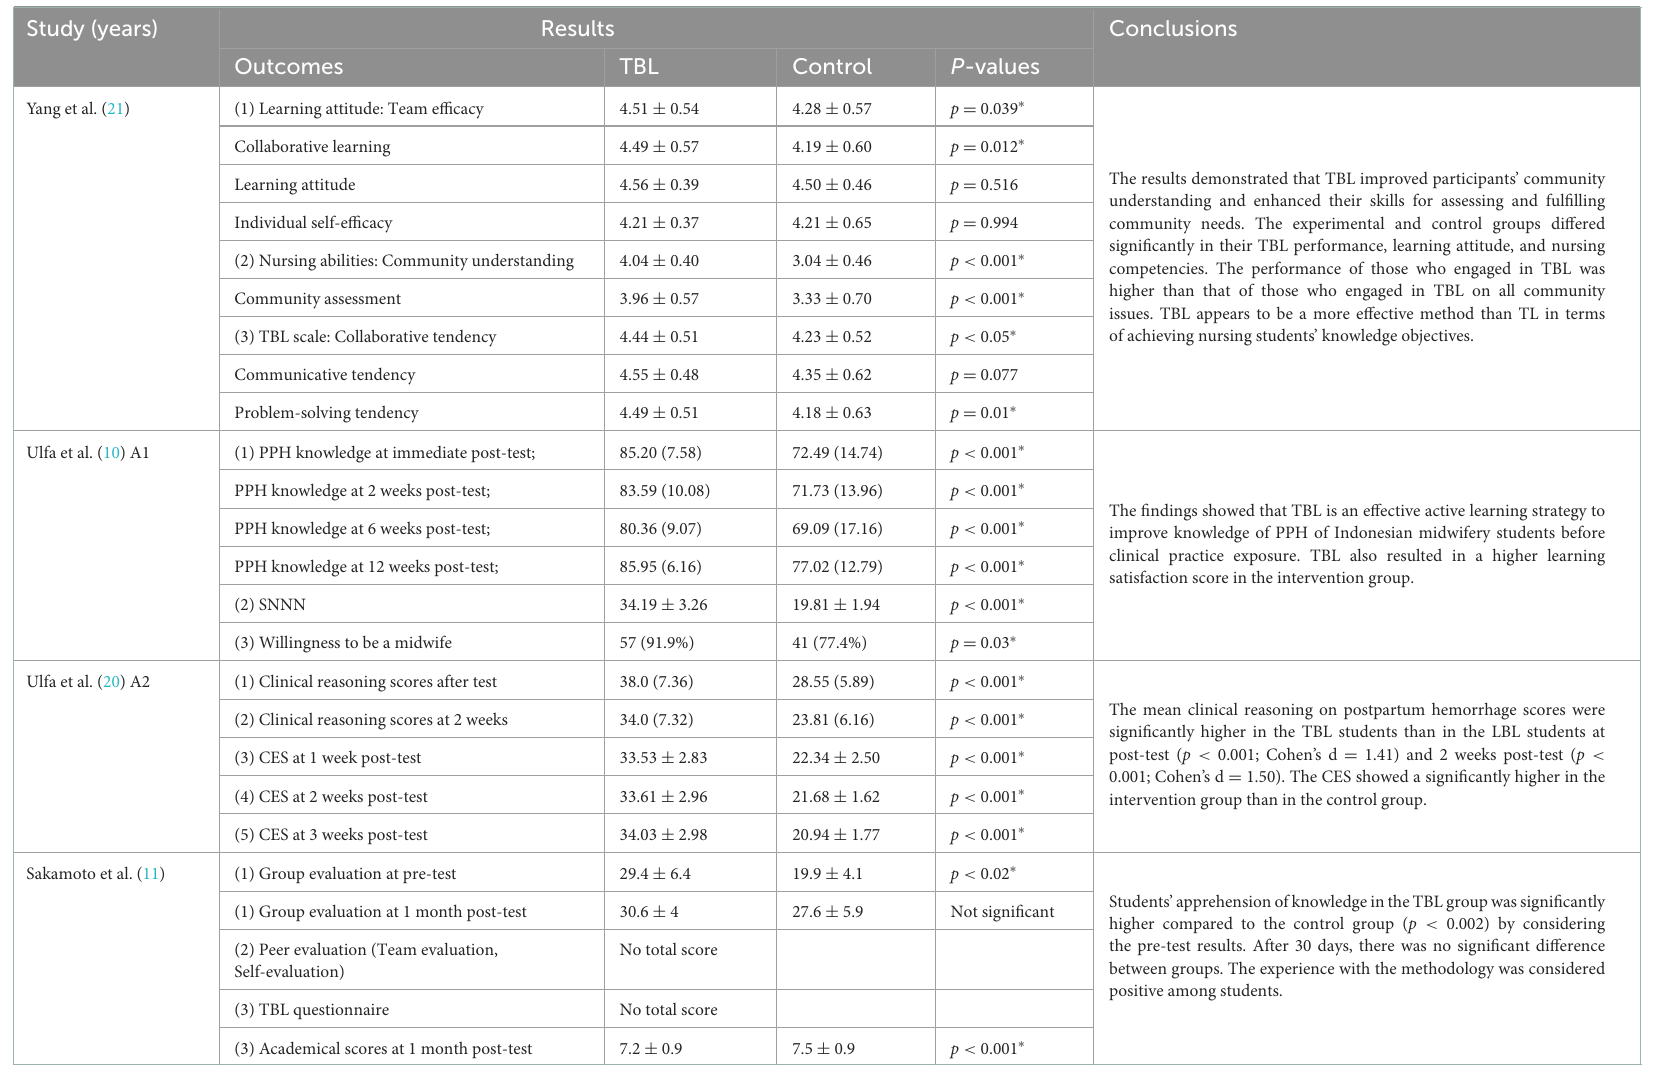
TABLE 3 The outcomes of included